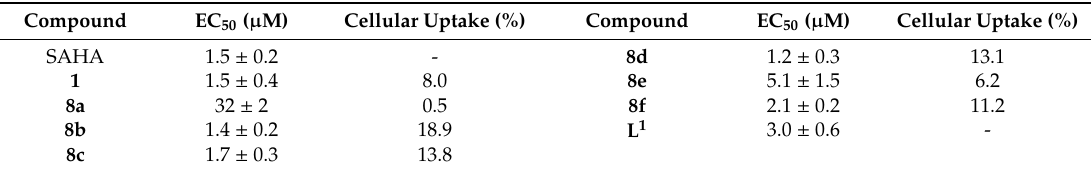
Table 2. In vitro EC 50 cell anticancer activity and cellular uptake measured against the MCF7 human breast adenocarcinoma cell line (96 h, using ChemoMetec Via1-Cassette assay). All assays carried out in triplicate. See Supplementary Materials for